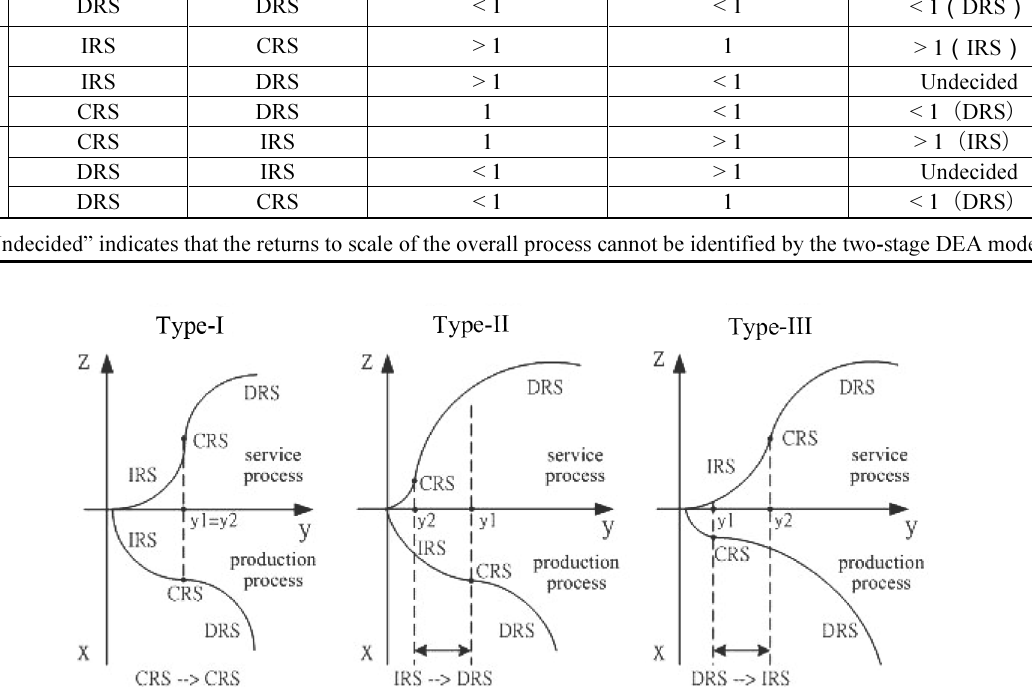
Fig. 5. Schematic diagram of the integrated returns to scale Fig. 5 products y 1 and y 2 represent the possible